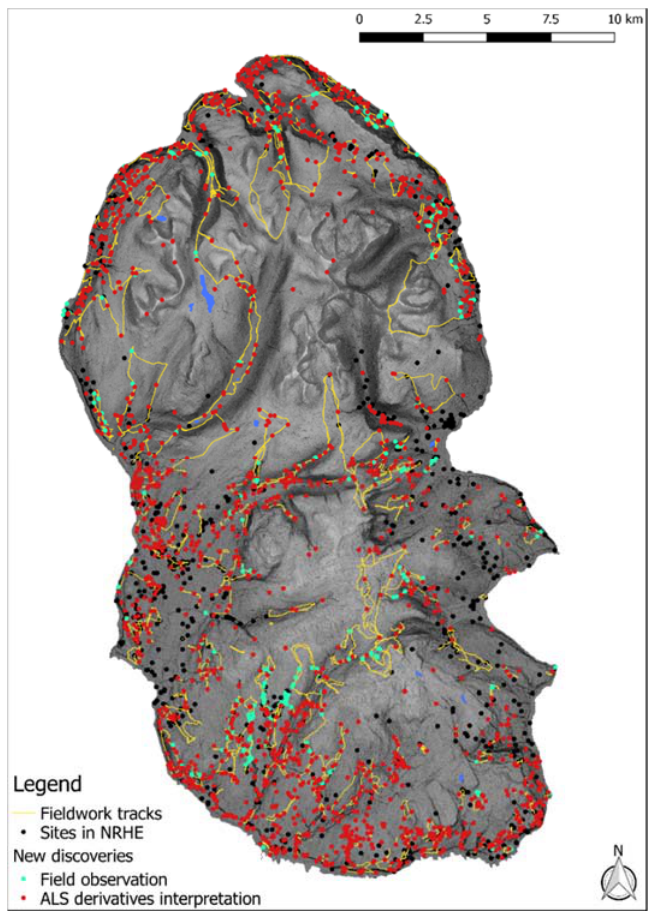
Figure 8. The distribution of archaeological sites identified during the project, shown against features known before the survey and fieldwork tracks superimposed on a terrain model. This map does not show large areas of dense coniferous plantations, within which reconnaissance was limited to gaps in the forest, while many of the mountainous areas in the north were judged to be beyond the likely limit of surviving archaeological remains. Glen Rosa, the L ‐ shaped trough valley in the northeast, was covered without a personal GPS unit and thus does not show any track. © Historic Environment Scotland (Sources: NRHE and ALS).